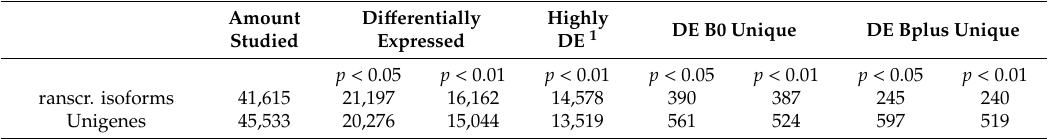
Table 1. RNA-seq-based di ff erential expression analysis in embryos of Ae. speltoides undergoing B chromosome